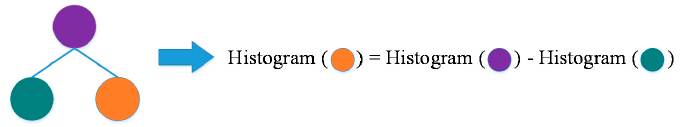
Figure 6. Process of decision tree learning using the growth of level-wise and leaf-wise.